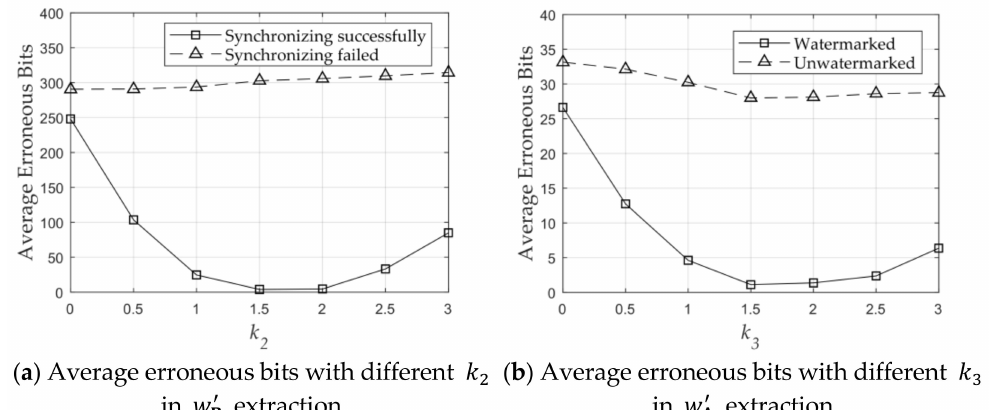
Figure 15. Erroneous bits with different message extraction thresholds.